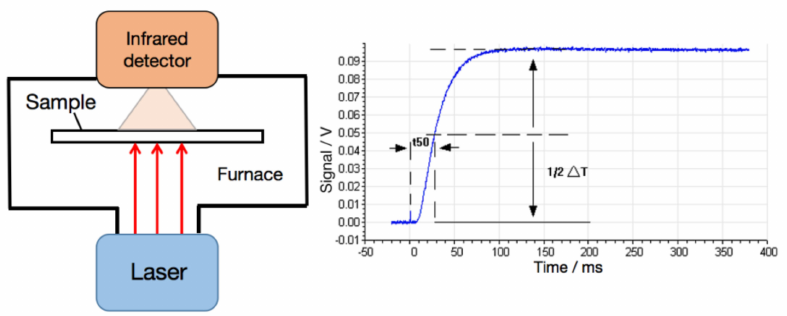
Figure 1. The principle of testing thermal di ff